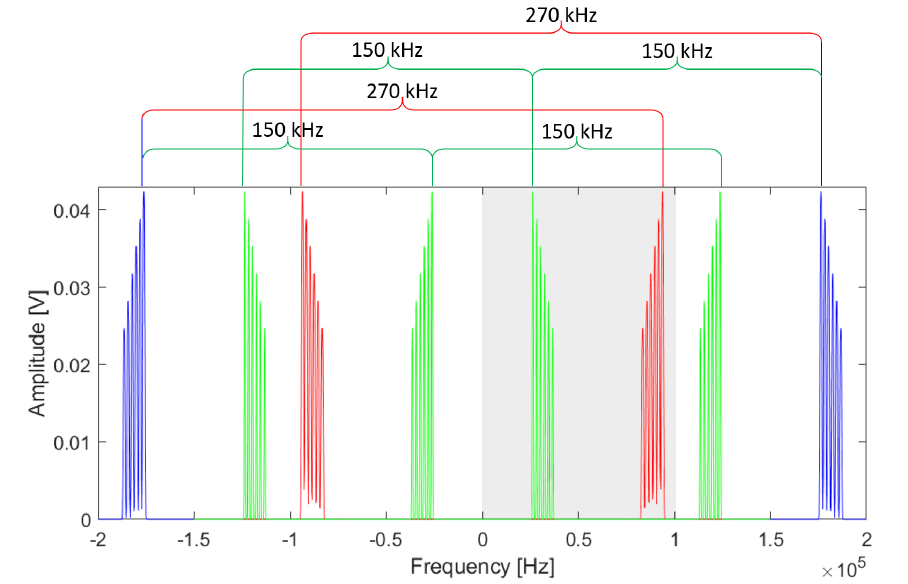
Figure 8. A visualization of band-pass sampling, where blue is the original signal spectrum X ( f ) , and red and green are the undersampled signal spectrum X S ( f ) in which red is f S = 270 kHz ( m = 1) and green is f S = 150 kHz ( m = 2): the discrete Fourier transform (DFT) returns only the spectral portion within the shadowed area of the